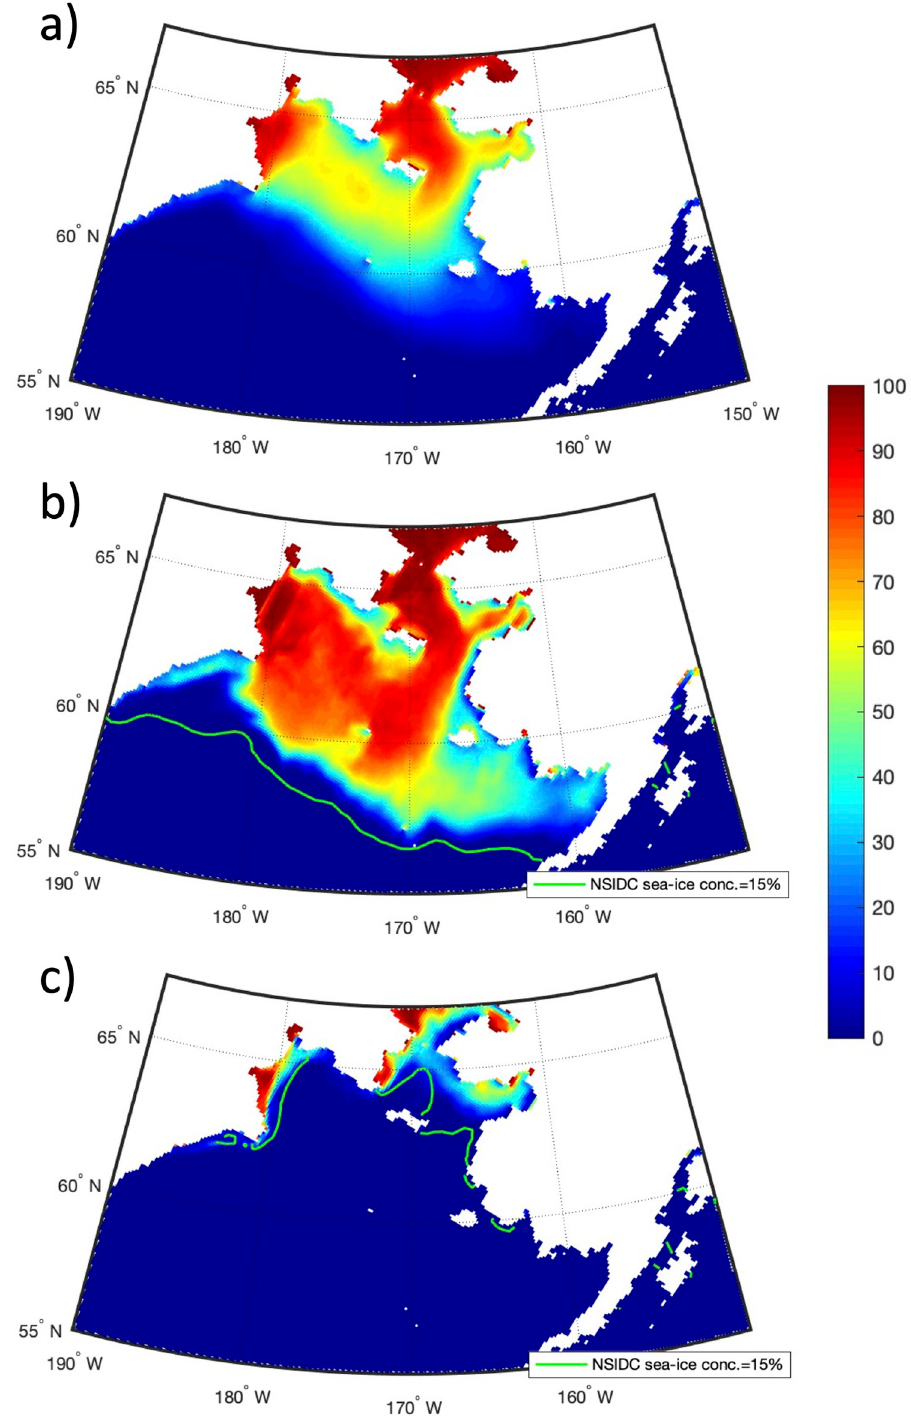
Fig 9. April sea ice concentration. April sea ice concentration (%) from RASM during 1980–2018 mean (a), 2012 (b), and 2018 (c). Observations from the National Snow and Ice Data Center satellite product [37] are shown as green lines for the 15% ice area contour. Figure created using Matlab (v. 2018a) from the authors’ data.